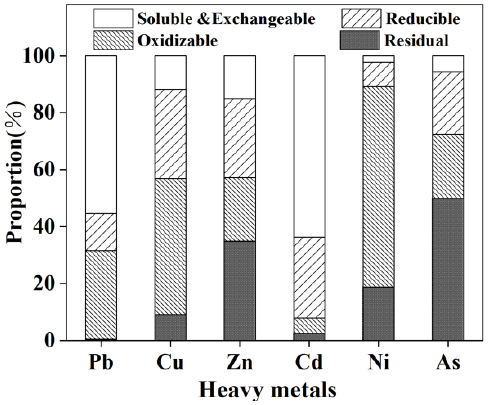
Figure 3. Heavy metal forms of MSWI fly ash.